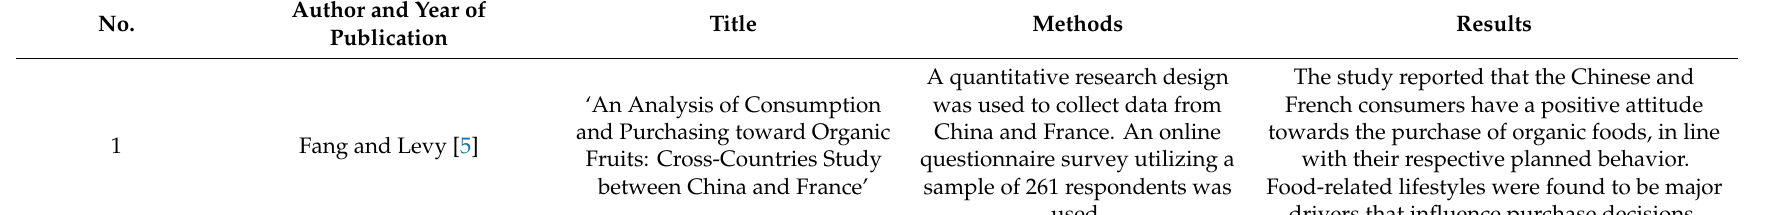
Table 1. Characteristics of the sampled